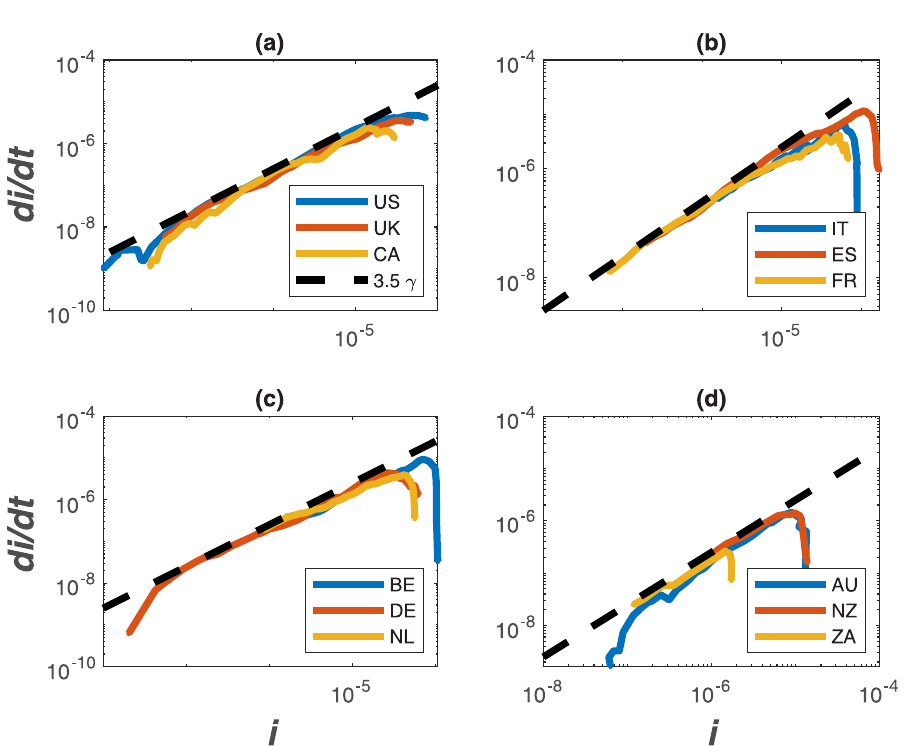
Fig 4. Same as Fig 3 but for sample countries. (a) the United States of America (US), the United Kingdom (UK), and Canada (CA); (b) Italy (IT), Spain (ES), and France (FR); (c) Belgium (BE), Germany (DE), the Netherlands (NL); (d) Australia (AU), New Zealand (NZ), and South Africa